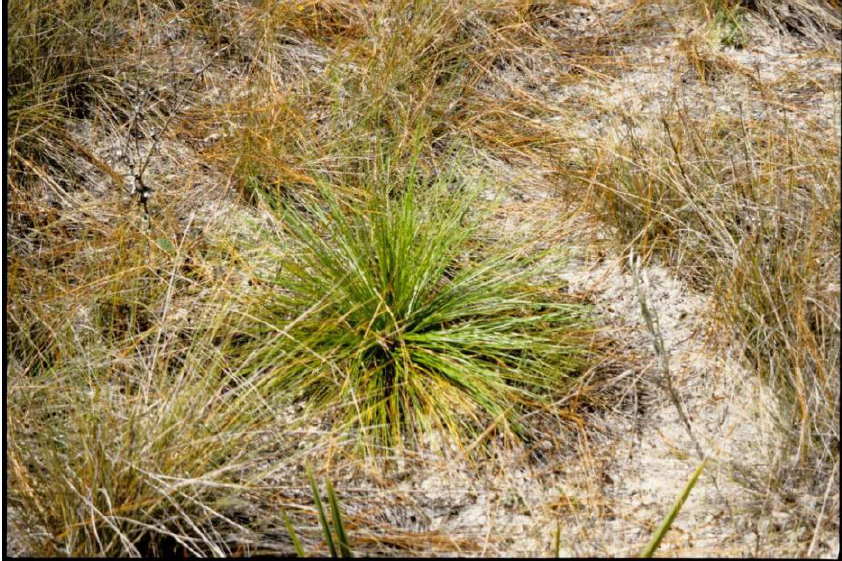
Figure 3. Longleaf pine grass stage (photograph by Marry Anne Sword, USDA Forest Service).